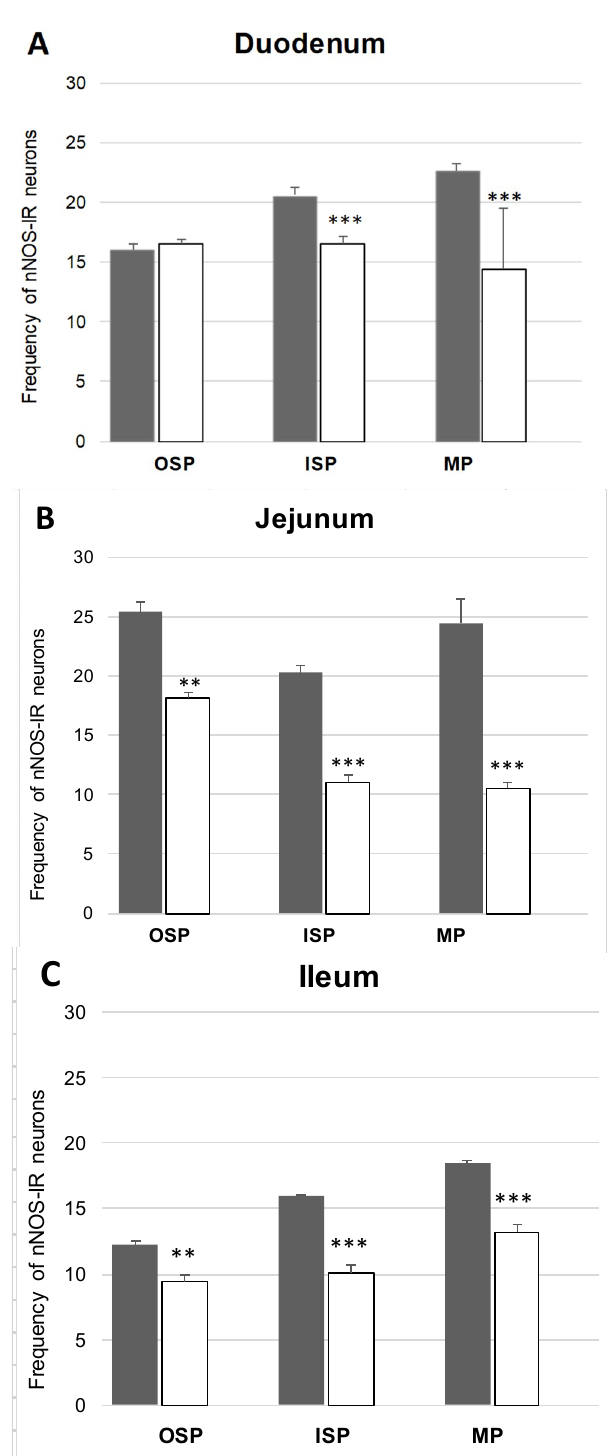
Figure 1. Neuronal nitric oxide synthase (nNOS)- positive cell bodies in inner submucous plexus (ISP), outer submucous plexus (OSP) and myenteric plexus (MP) within the duodenum, jejunum and ileum in the control and experimental groups. Mean ( ± SEM) percentage of neurons immunoreactive to nNOS in the OSP- intestinal outer submucous plexus, ISP- intestinal inner submucous plexus, MP- myenteric plexus in the duodenum ( A ), jejunum ( B ) and ileum ( C ). Control (grey bars), experimental (white bars), ** p < 0.01, *** p < 0.001—indicate differences between control and experimental group.